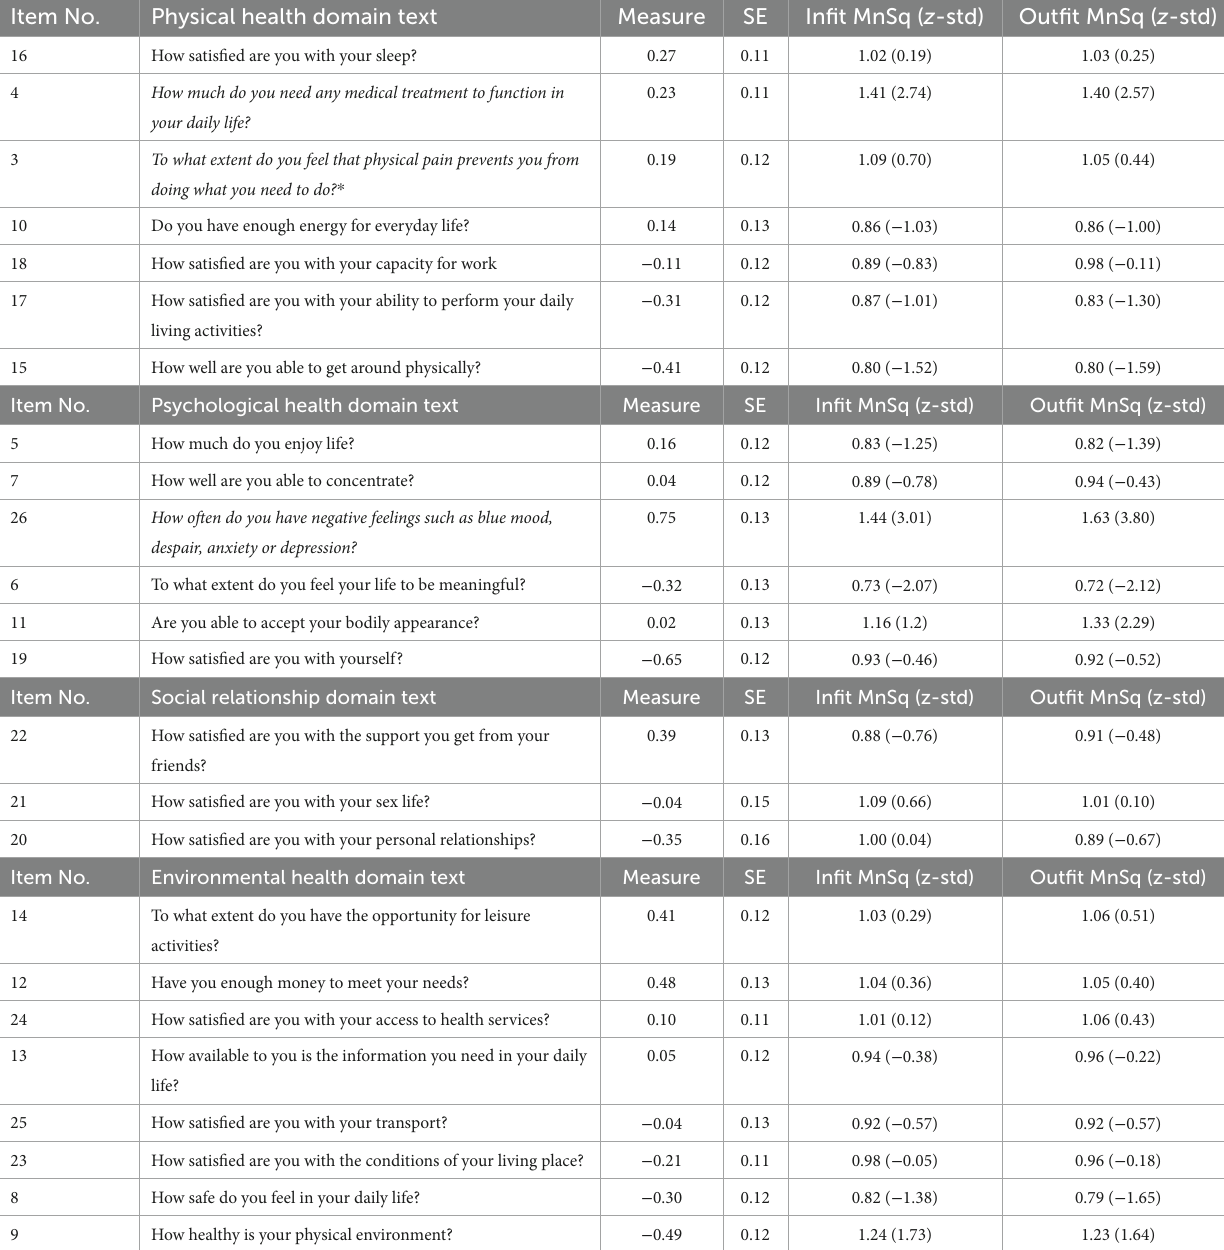
TABLE 6 Item difficulty, Rasch fit statistics for each item within the four domains in WHOQOL-BREF. Item